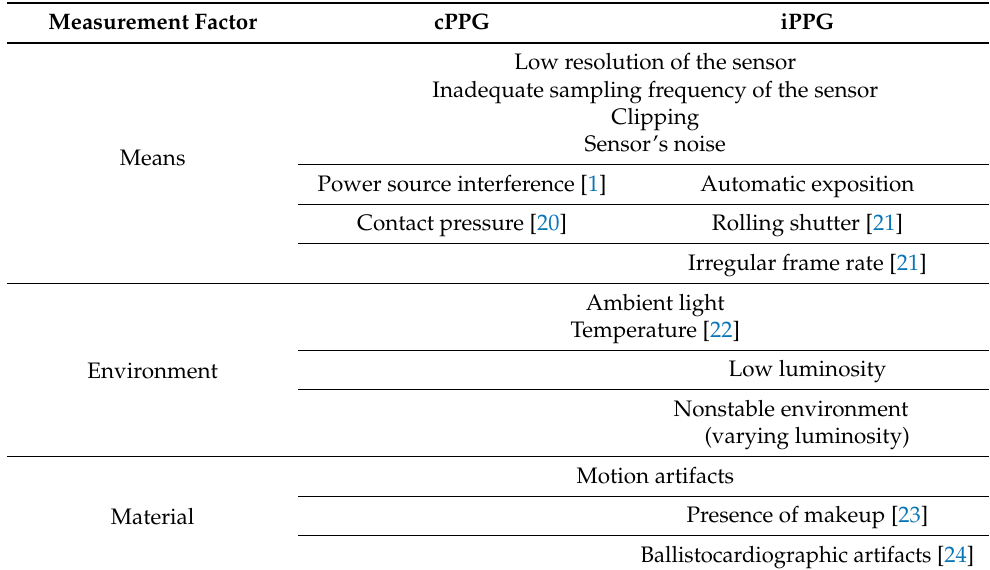
Figure 1. Ishikawa diagram presenting the factors influencing a photoplethysmographic measurement. From each factor, perturbations can affect the quality of a PPG measurement (Table 1). Table 1. Non-exhaustive perturbations affecting a PPG